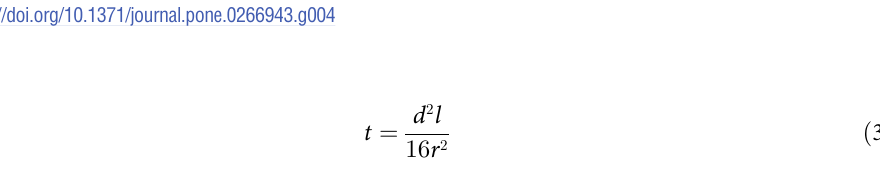
Fig 4. Schematic layout of the thermal evaporation set-up used to deposit carbon layers using the Emitech carbon coater. The t symbol denotes the time in seconds, r denotes the radius between the rod and the specimen, d refers to the diameter of the rod and L denotes the evaporation